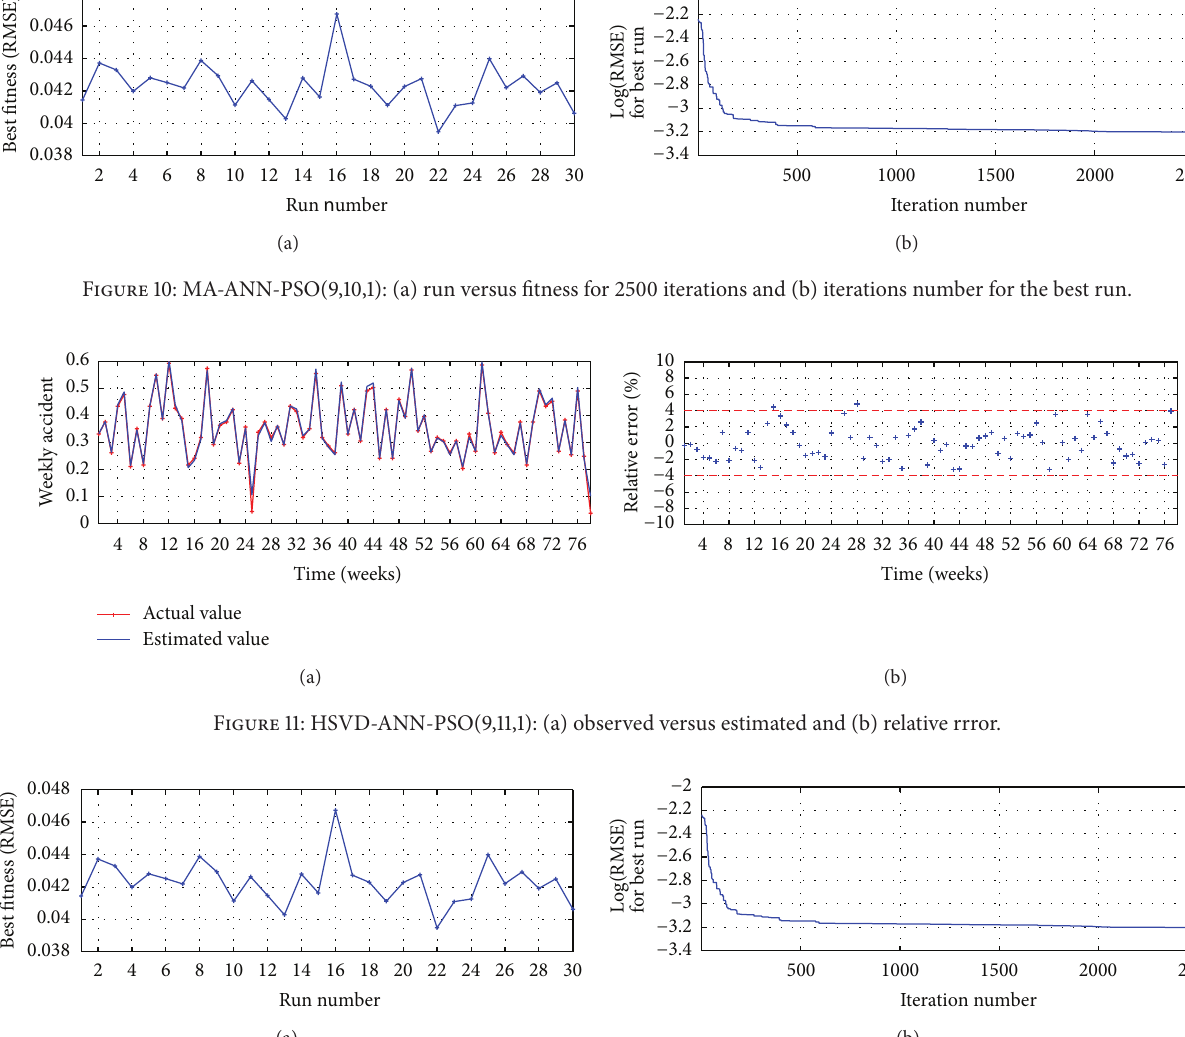
explained in Section 5.1.2; then an ANN (𝐾, 𝑄, 1) is used, with 𝐾 = 9 inputs (lagged values), 𝑄 = 11 hidden nodes, and 1